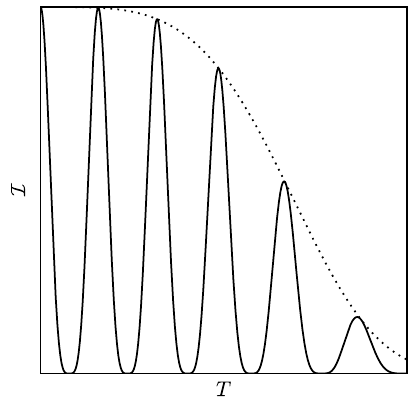
Figure 3. A schematic of the echo signal strength, I , as a function of interferometer time, T , for an interferometer in a negative residual trapping potential, i.e., β < 0. Like the positive potential case, the signal strength is periodic and contained within a decaying envelope. However, the negative potential causes a decreasing frequency. Both positive and negative potentials have the same